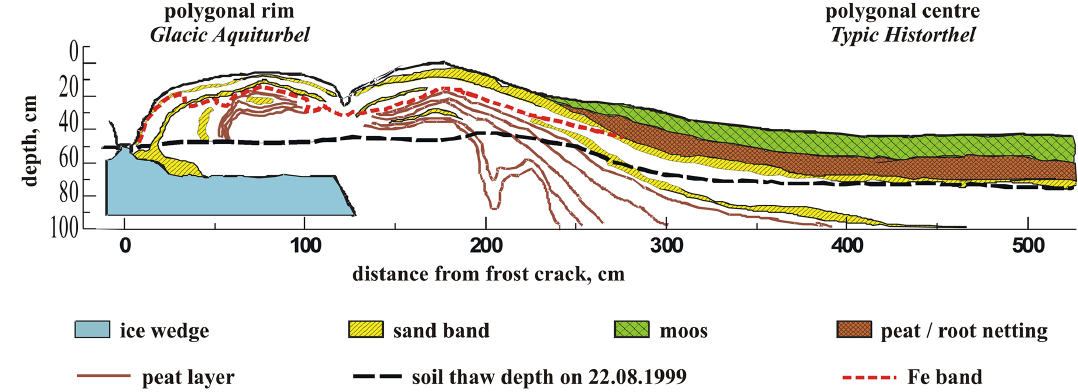
Figure 11. Cross section of a low-centred polygon with a surface depression above the ice wedge and another one at the ice wedge’s end. Soils that have developed in this polygon are a Glacic Aquiturbel at the polygon rim above the ice wedge and a Typic Historthel in the polygon centre. Scheme compiled from field observations of 22 August 1999.